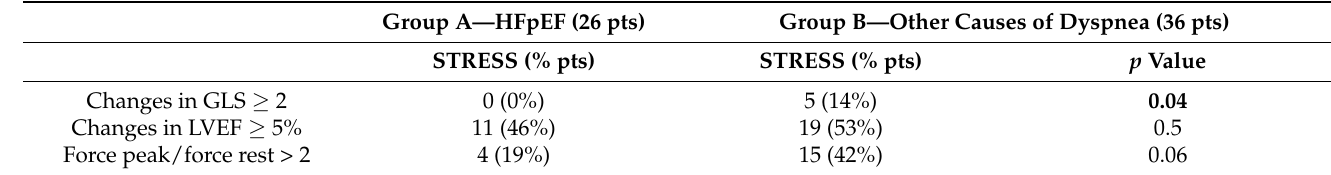
Table 3. Preserved left ventricular contractile reserve (LVCR) in groups A and B. Group A—HFpEF (26 pts) Group B—Other Causes of Dyspnea (36 pts) STRESS (% pts)